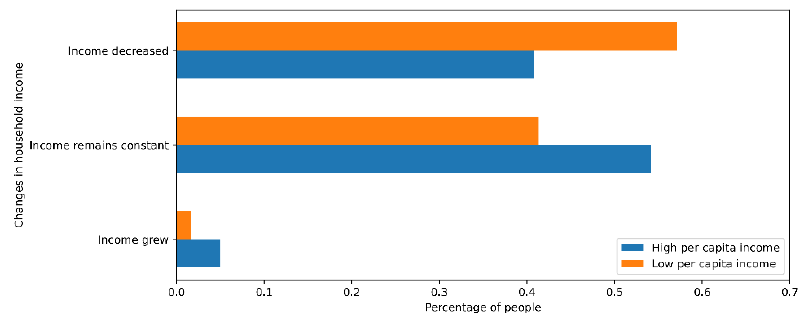
Figure 5. Changes in household income during the pandemic.